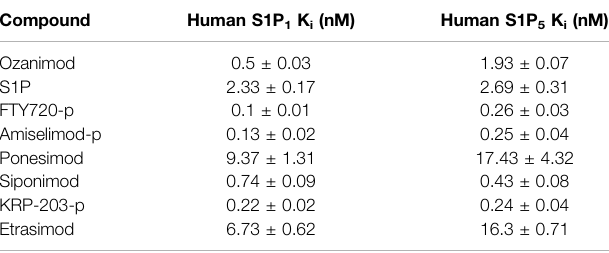
TABLE 1 | Radioligand binding af fi nities for human S1P 1 and S1P 5 . Compound